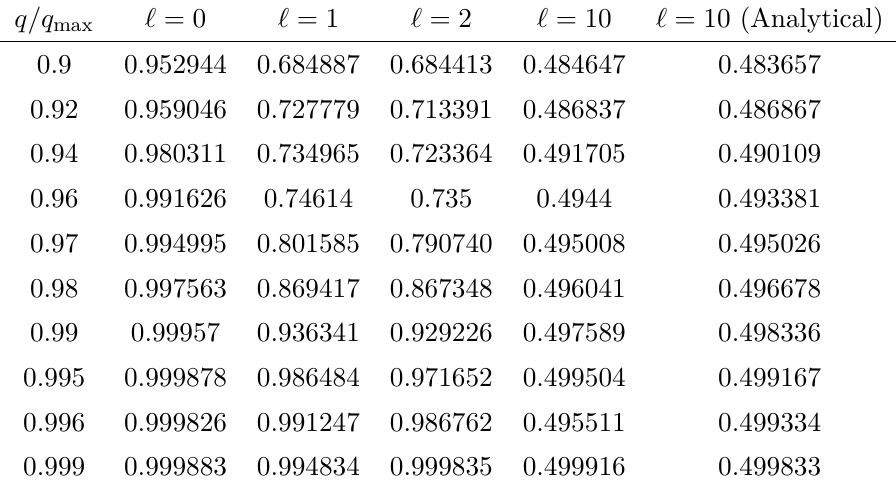
Table 1 . Numerical values of the ratio {− ( Im ω n,l ) /κ − } have been presented for the lowest lying QNMs for different choices of the angular momentum ‘ and the ratio ( q/q max ) . Here we have considered the value of the AdS length scale and the mass of the black hole to be, L = M = 1 . Therefore, the strong cosmic censorship conjecture is respected for a charged BTZ black hole in comparison to the rotating